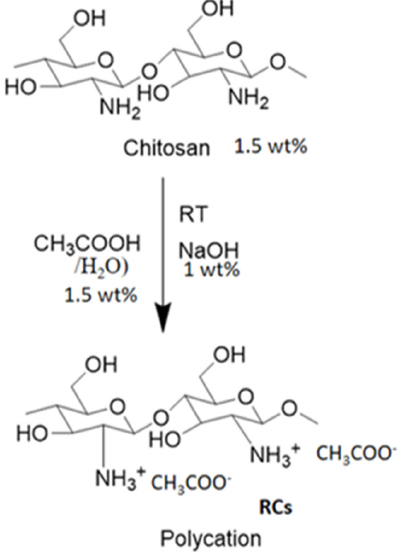
Figure 4. Chemical reaction pathway for synthesis of regenerated chitosan.